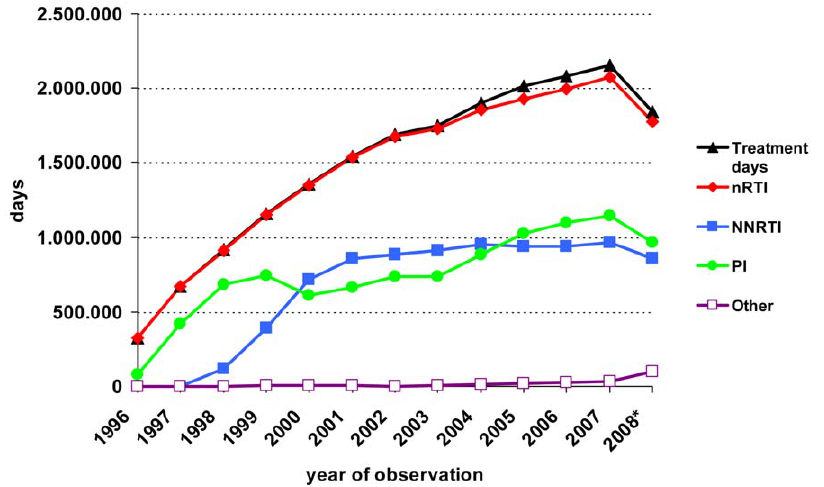
Figure 1. Cumulative use (in days) of antiretroviral classes by year. (* The decrease of treatment days in 2008 is explained by a reporting delay for some of the most recent cases within the database at the end of the observation period).